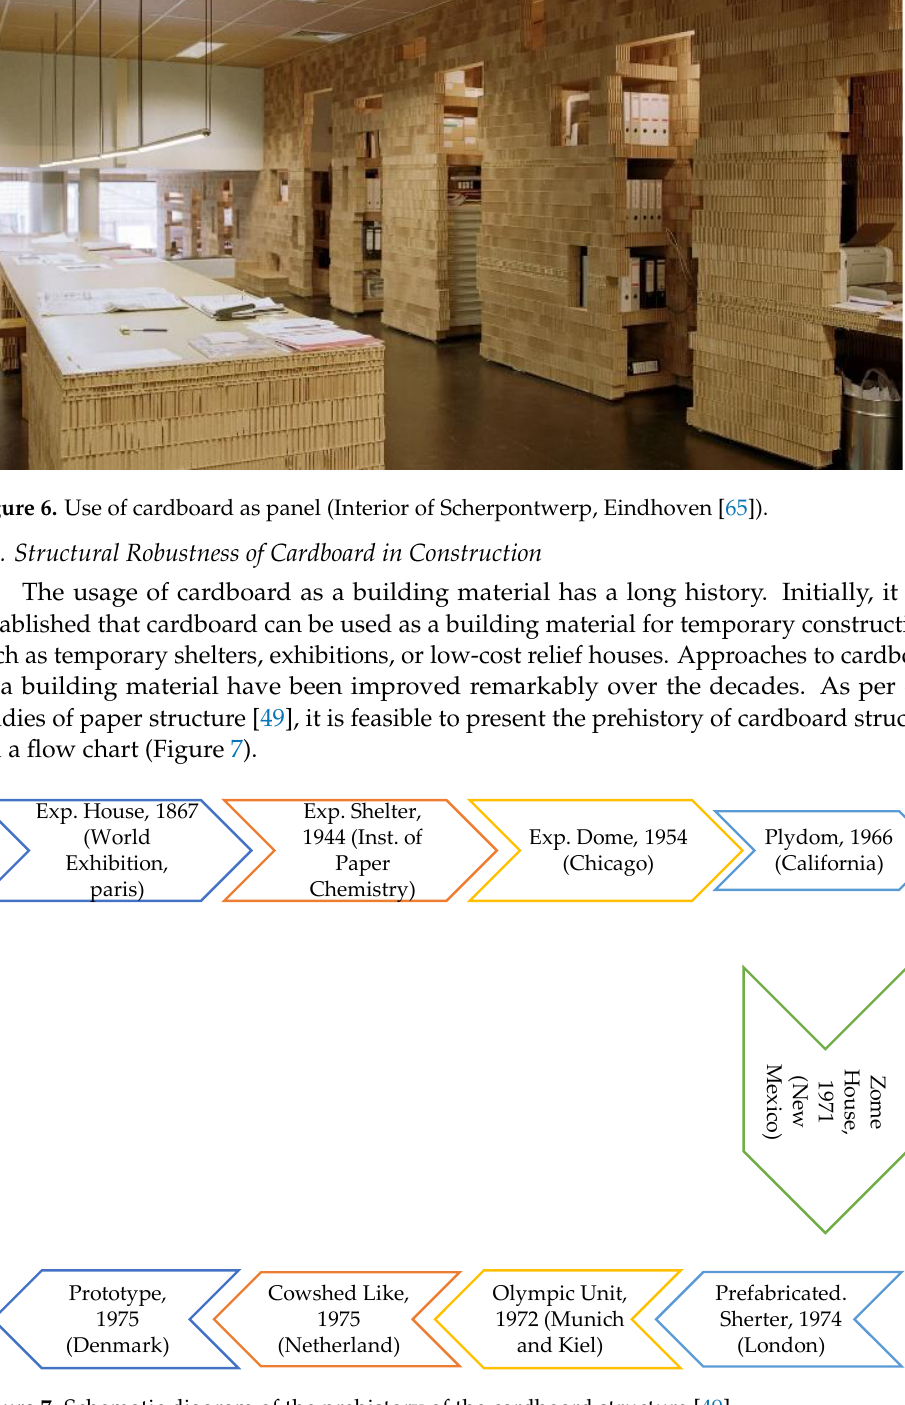
Figure 5. Use of cardboard as tube in construction (Takatori Catholic Church [64]).